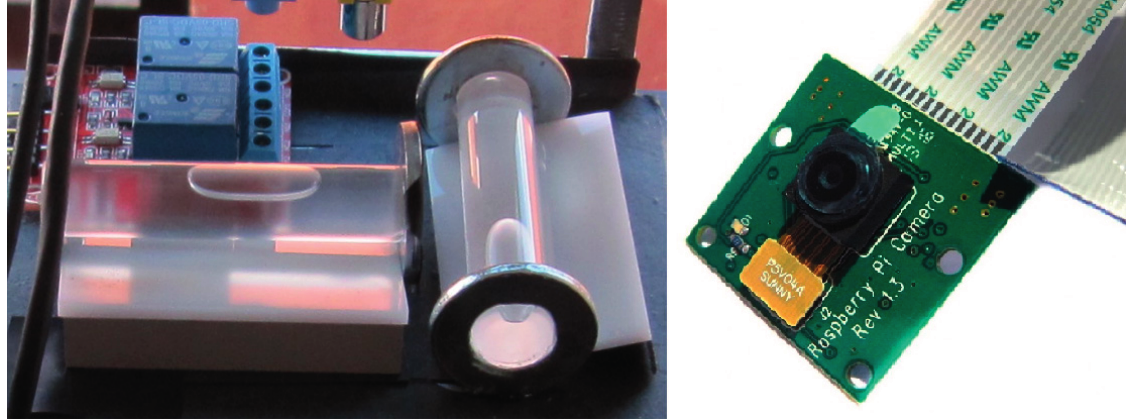
Figure 2. ( Left ) The spirit vials and the lighting module; ( Right ) The Pi Camera